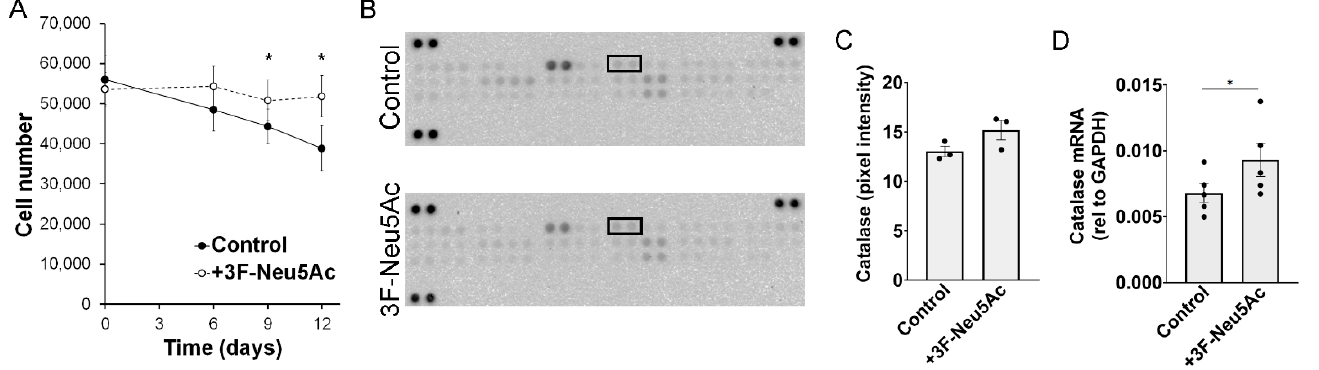
Figure 4. Pre-treatment with 3F-Neu5Ac promotes survival of MSCs in vitro. ( A ) MSCs were cultured for 2 days with or without 3F-Neu5Ac (50 μ M). Then, media was changed to serum free media (MEM- α only) and cells transferred to an incubator with 1% oxygen, mimicking an ischemic environment. ( A ) At indicated time points, cells were lifted and counted using Trypan blue exclusion dye and hemocytometer. MSCs pre-treated with 3F-Neu5Ac had significantly higher survival rates after days 9 and 12 in hypoxia (n = 5). ( B ) Representative images of the Apoptosis Proteome Array using lysates from MSCs after 6 days under “ischemia”. Black boxes highlight catalase expression analysis. ( C ) Quantitative representation of pixel intensity for catalase expression on apoptosis array (n = 2). ( D ) 3F-Neu5Ac pre-treatment caused an increase of catalase mRNA expression 6 days after nutrient and oxygen deprivation. Statistical analysis was performed by Student’s t test; * = p < 0.05.